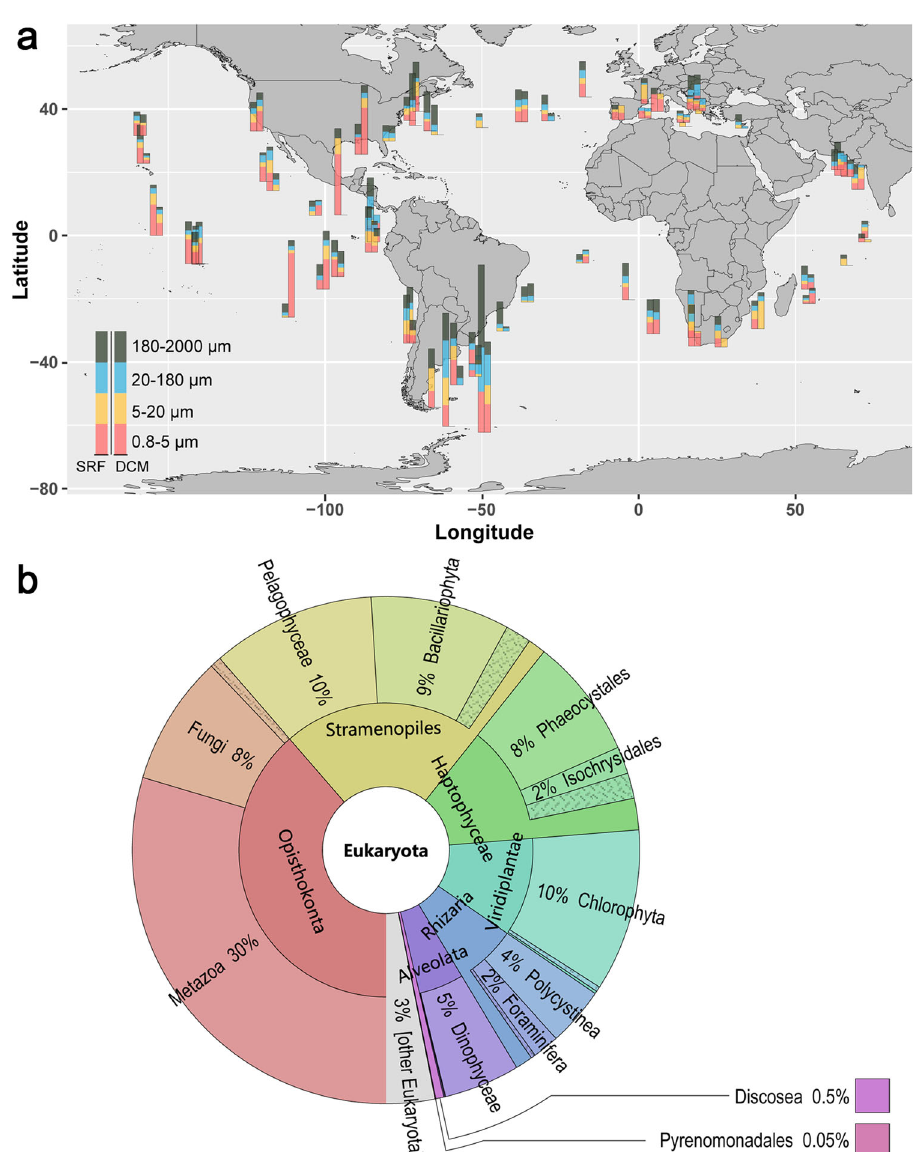
Fig. 4 The distribution and expression of the SPX genes across phytoplankton species and in the global oceans. a World map of the quantitative geographical distributions of SPX domain-containing genes. The expression values were computed as RPKM (reads per kilo base covered per million of mapped reads). The expression of SPX domain-containing genes were normalized to the total number of mapped reads. SRF subsurface, DCM deep chlorophyll maximum layer. The SRF layer and DCM layer were displayed on the left and right, respectively. Color of the squares depicts the size fractions of the sample. b Krona pie-charts showing the taxonomic distribution of SPX-domain-containing